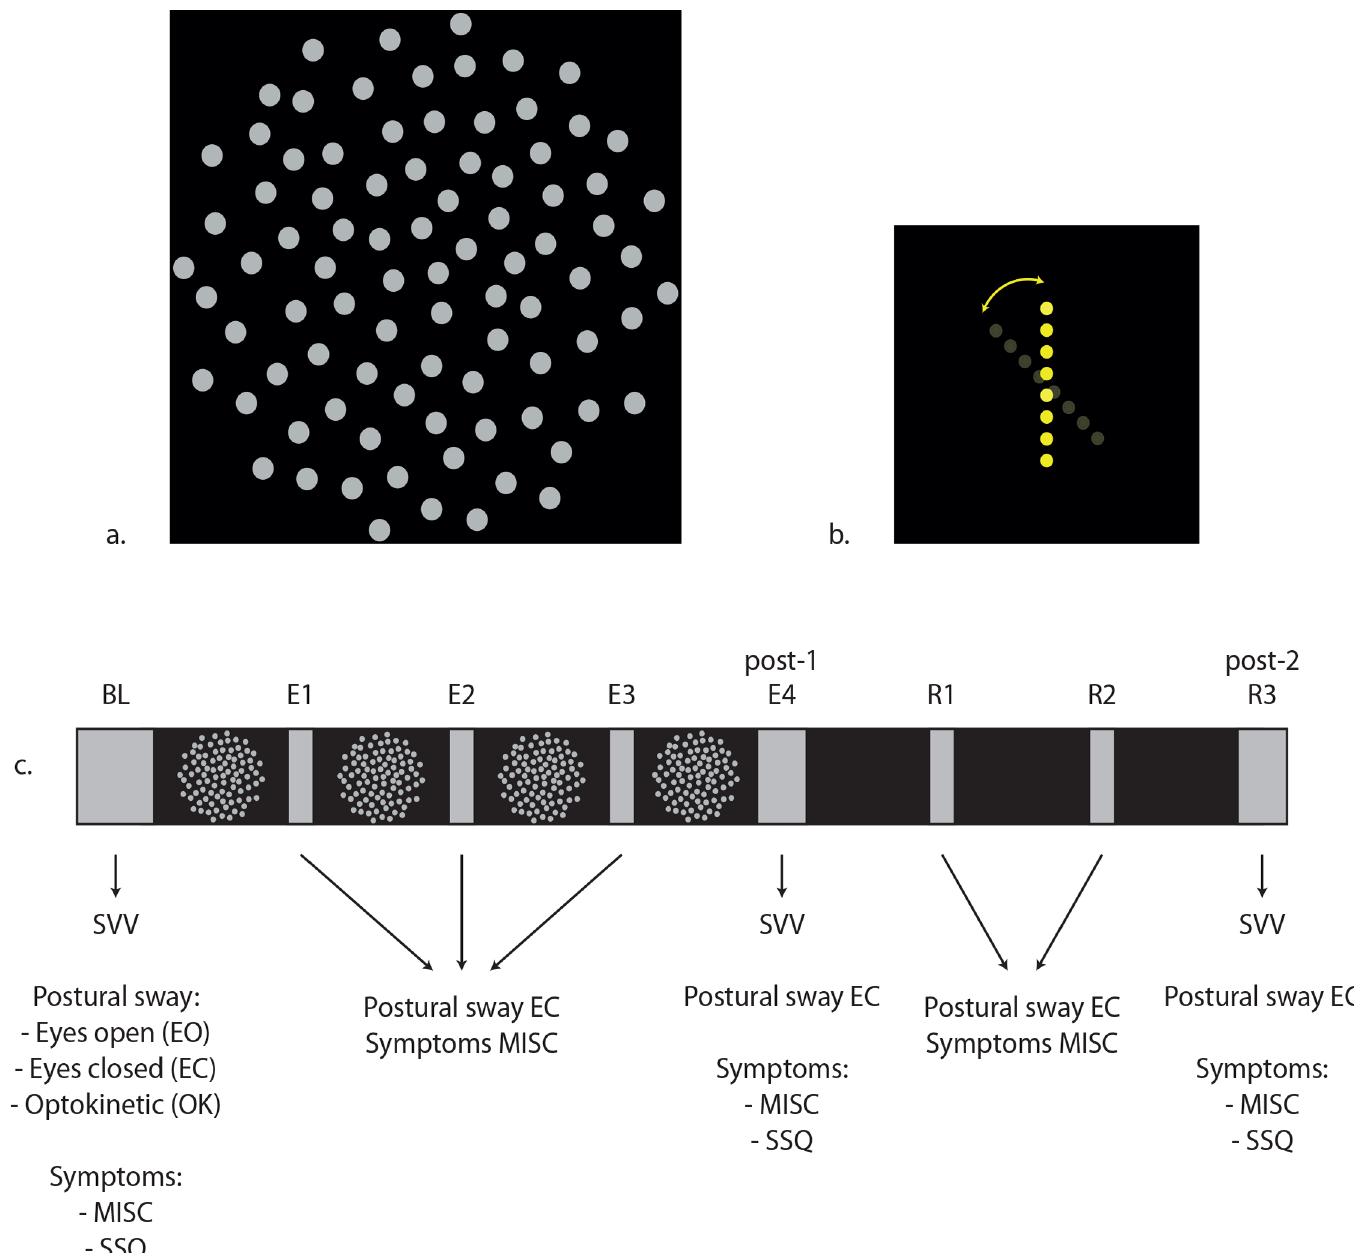
Fig 1. a. The dot pattern, b. The subjective visual vertical, and c. Flow chart of the procedure. Participants took part in two sessions following this procedure. In one session the dot pattern remained stationary during exposure (still session), while in the other session the dot pattern rotated (moving